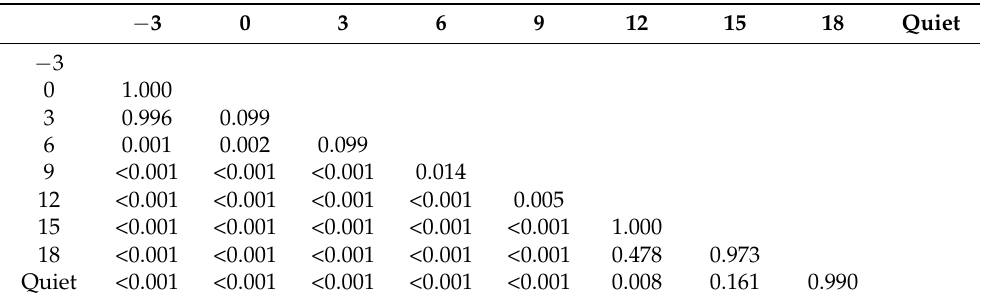
Table 2. Summary of post hoc p -values in the adaptive VRB test according to the different quiet and noise (relative dB SNRs) conditions.